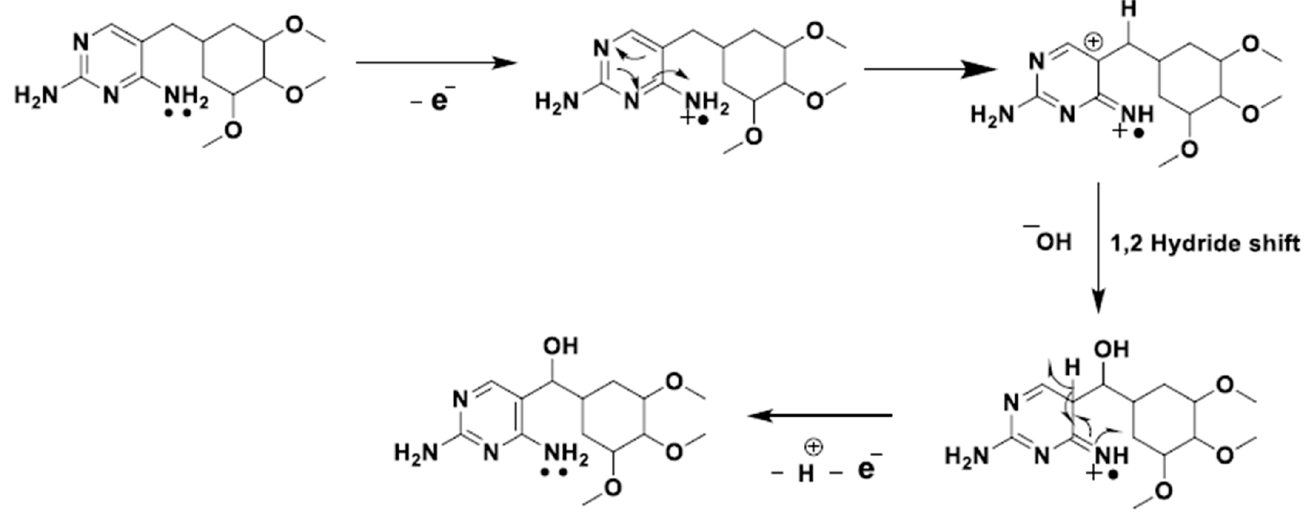
Figure 5. Possible two-electron oxidation mechanism of trimethoprim. (Reproduced from Patil et al. [42], with permission from MDPI, 2022).